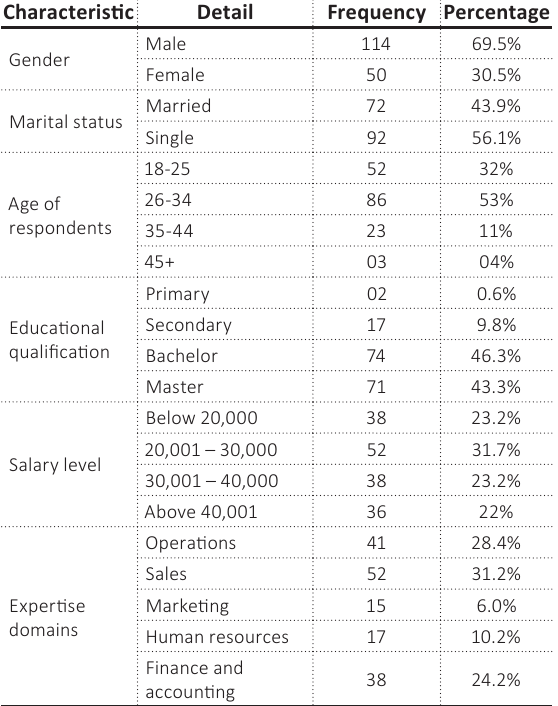
Table 1. Summary of socio-demographic characteristics of